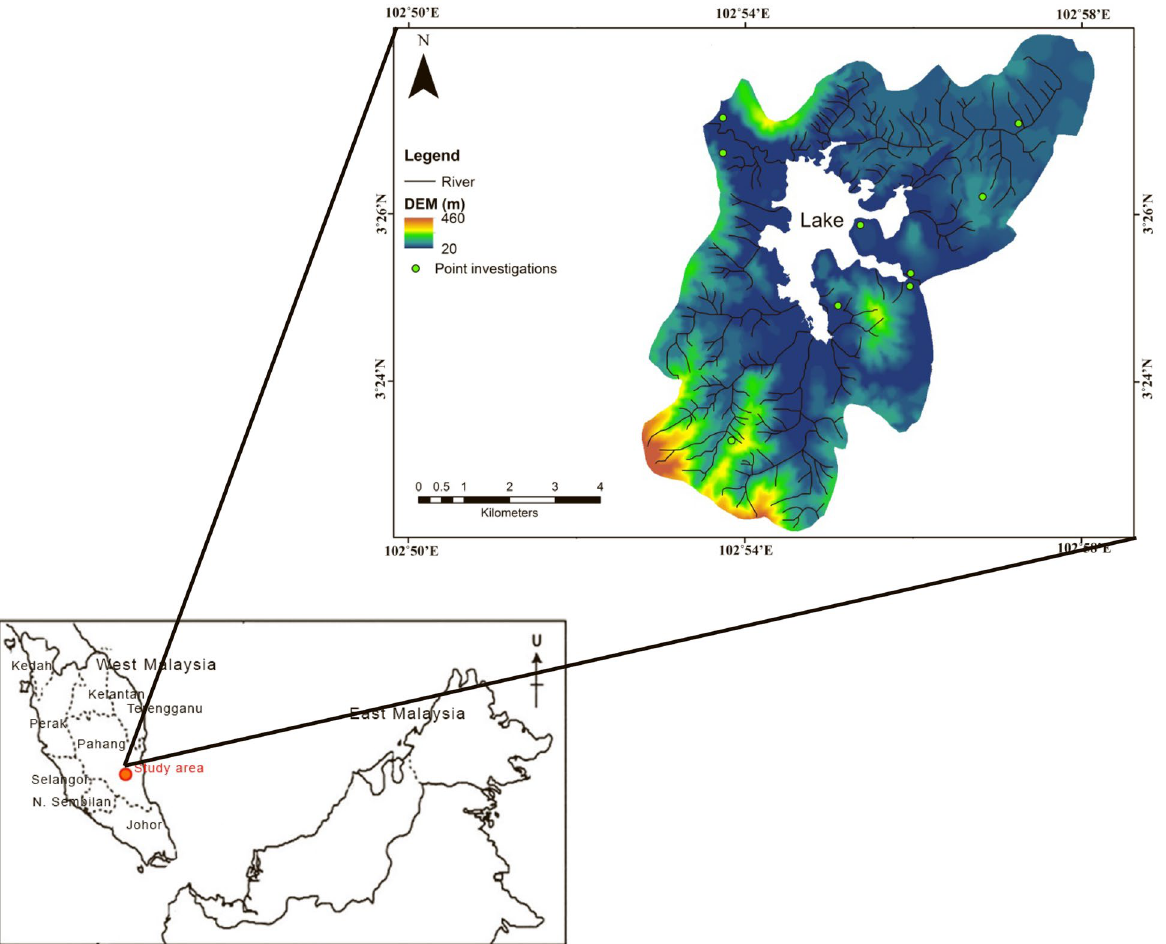
Fig. 1 Study area with points of soil sampling presented on the digital elevation model (DEM)